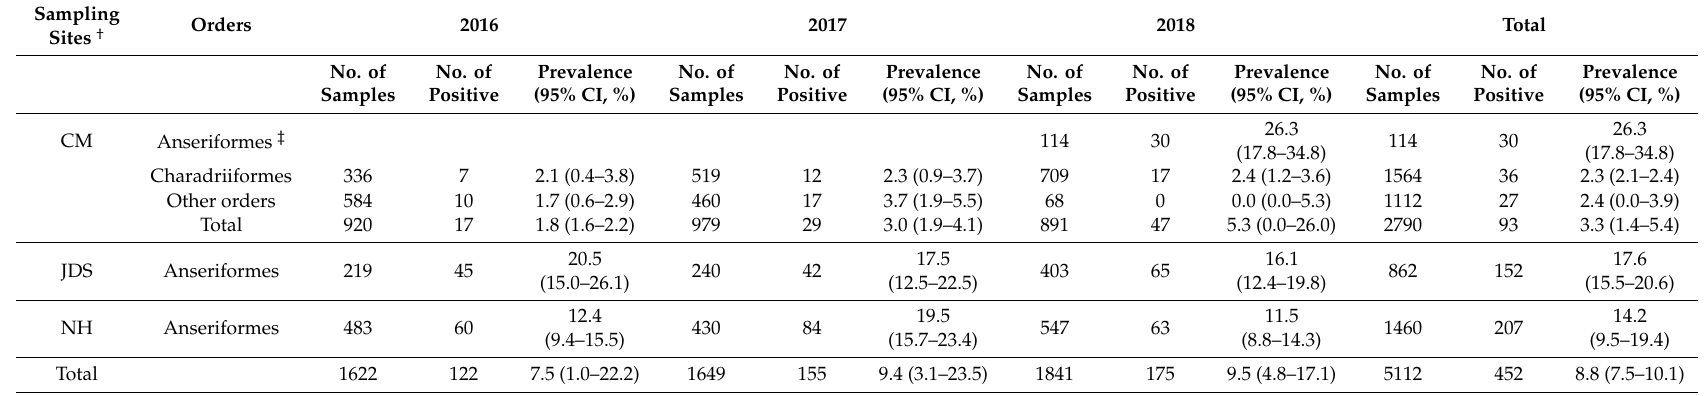
Table 1. Prevalence of influenza A virus in wild birds in Shanghai,